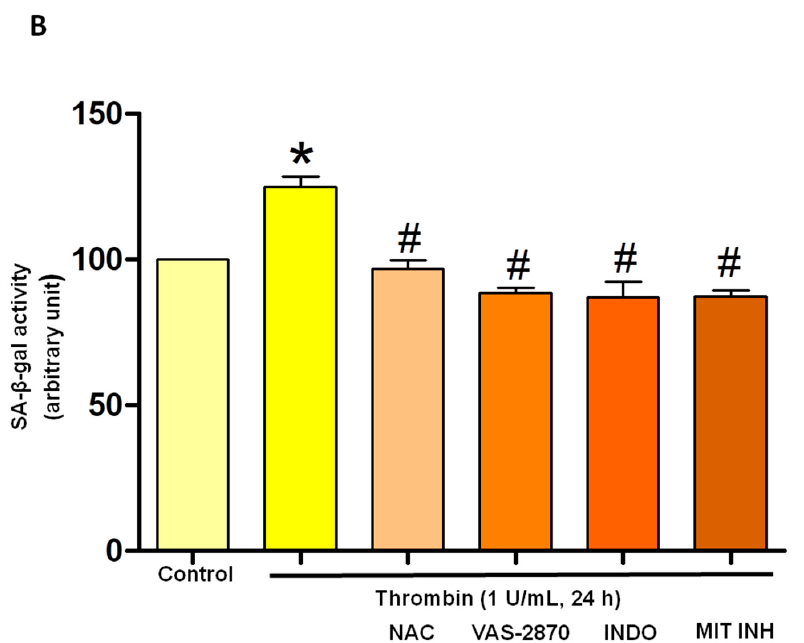
Figure 2. Thrombin induces oxidative stress promoting senescence in atrial ECs. ( A ) Atrial ECs were either untreated or exposed to N-acetylcysteine (NAC, an antioxidant), VAS-2870 (VAS, NADPH oxidase inhibitor), indomethacin (INDO, COX inhibitor), SC-560 (COX-1 inhibitor), NS-398 (COX-2 inhibitor) or a mitochondrial inhibitory complex (MIH; rotenone; KCN; myxothiazole) before the addition of thrombin (1 U/mL, 1 h) and dihydroethidium (DHE) to determine the level of oxidative stress by confocal microscopy. Upper panels represent ethidium staining and lower panel corresponds to cumulative data. ( B ) Atrial ECs were either untreated or exposed to NAC, VAS, INDO or MIH before the addition of thrombin (1 U/mL, 24 h) and subsequent determination of SA- β -gal activity using flow cytometry. Results are shown as mean ± SEM of n = 3–4 different experiments. * P < 0.05 versus respective control, # P < 0.05 versus thrombin-treated atrial ECs.